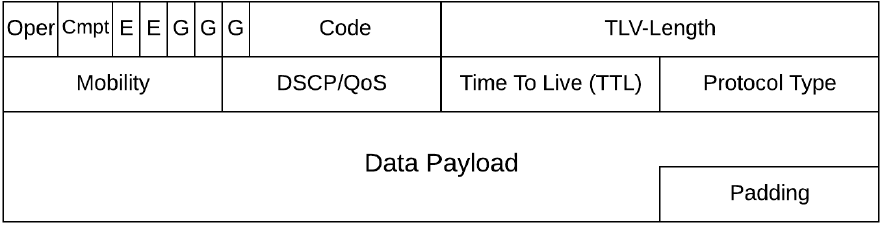
Figure 3. CETP Payload TLV